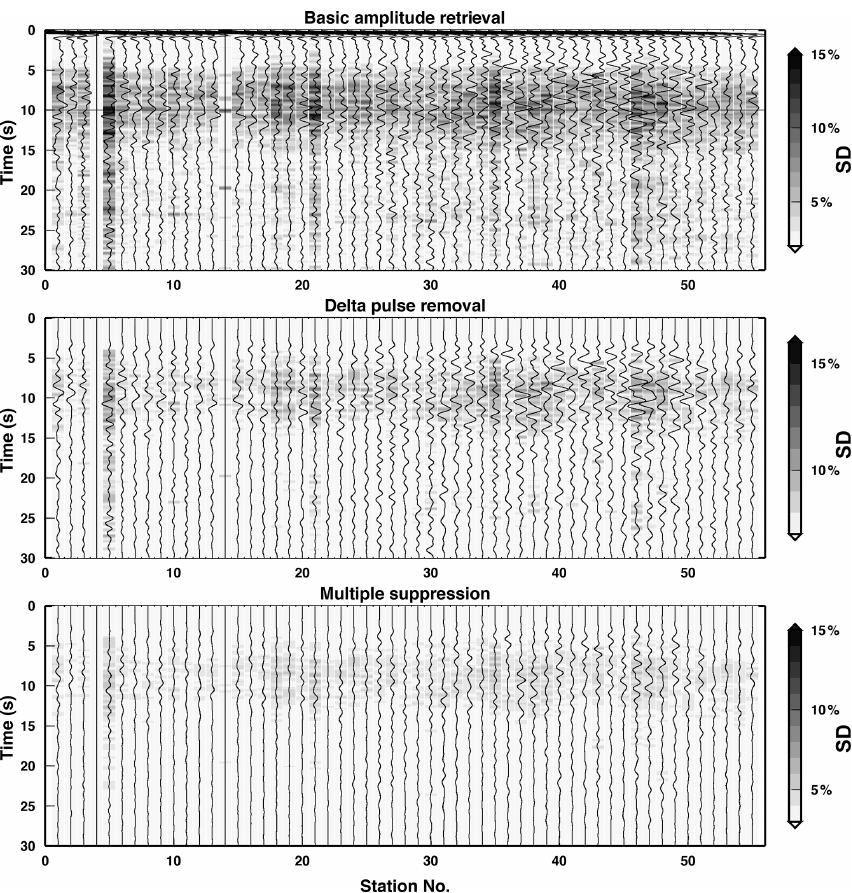
Figure 3. Standard deviation calculated over 100 samples generated by bootstrapping events ensembles by the pool of 64 events (Table 1). Mean wiggles are displayed on top of the SD. The SD for times larger than 15s is very low due to the absence of strong reflectivity in this time